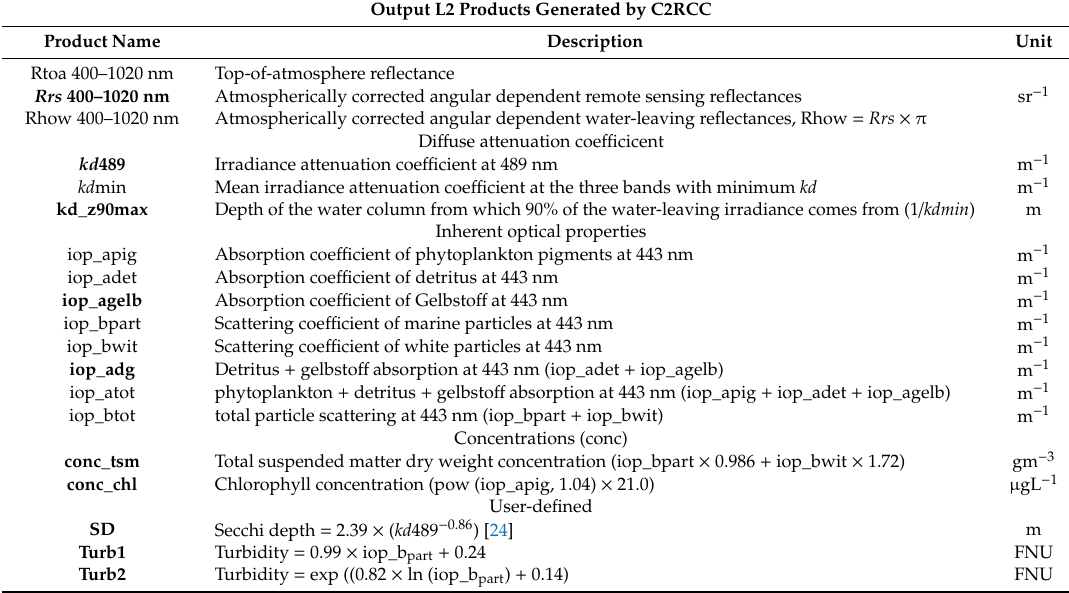
Table 5. The output L2 products generated by C2RCC [18]. The products in bold were validated in this